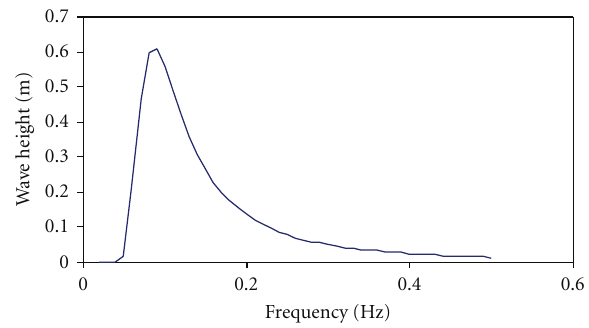
Figure 6: Irregular incident wave spectrum with the peak frequency ω p = 0 . 586 and the significant wave height, SWH = 6m.